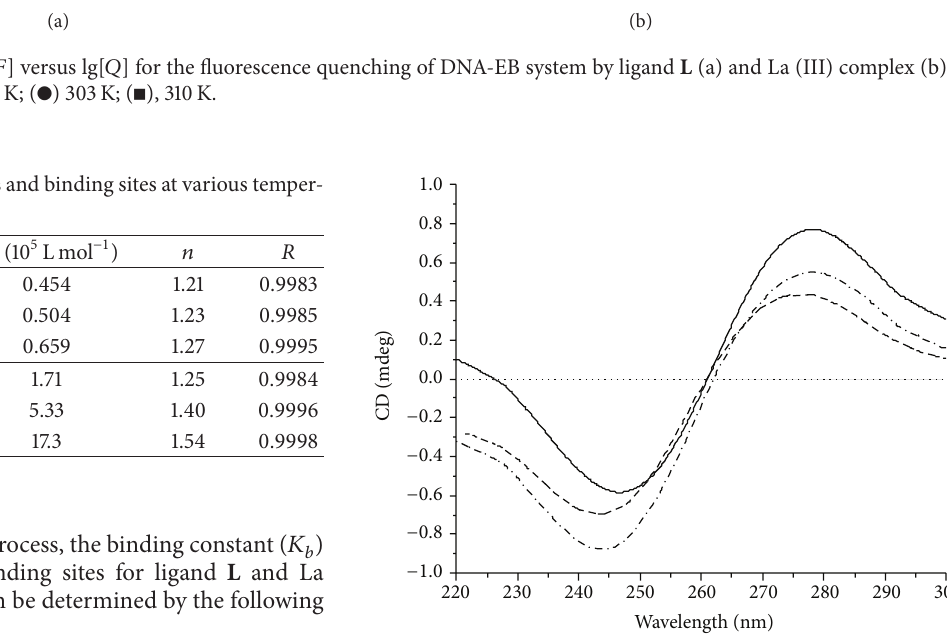
Figure 6: CD spectra of CT-DNA (100 𝜇 M) in the absence and presenceofthecompounds(20 𝜇 M).ThesolidlineisforDNAalone, the short dash line for DNA + ligand L , and the dash line for DNA + La (III)